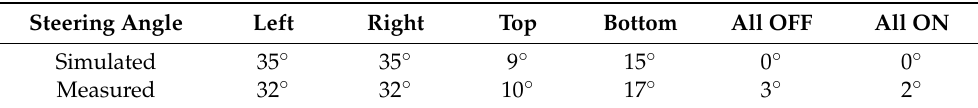
Table 3. Summary comparison between the simulated and measured results of the tilting angle for all switch configurations.